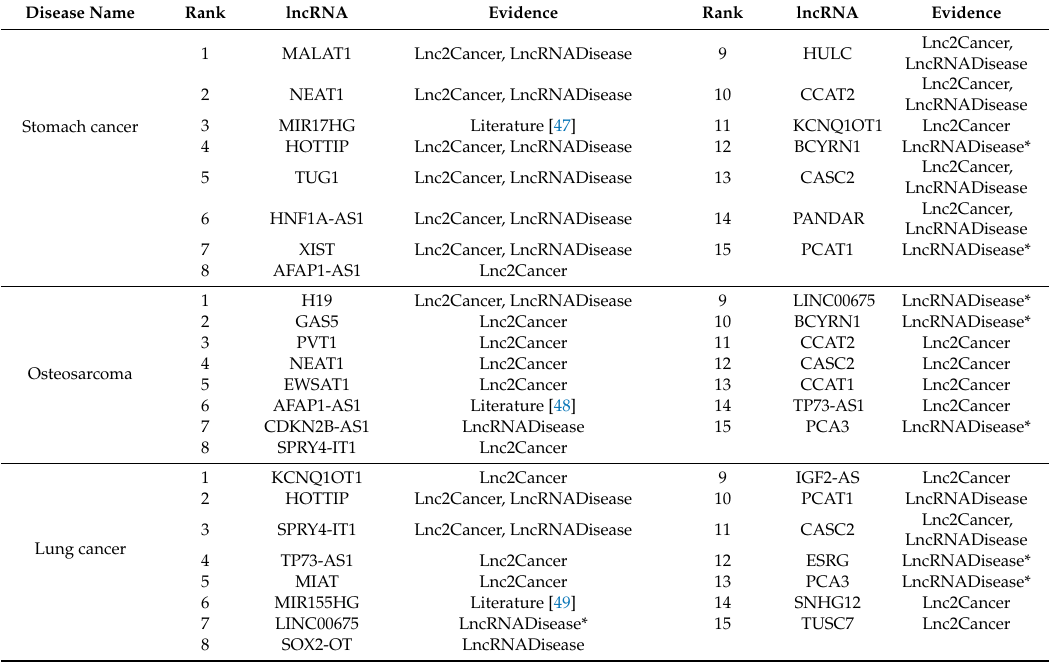
Table 4. The top 15 candidate lncrnas for stomach cancer, osteosarcoma and lung cancer. Disease